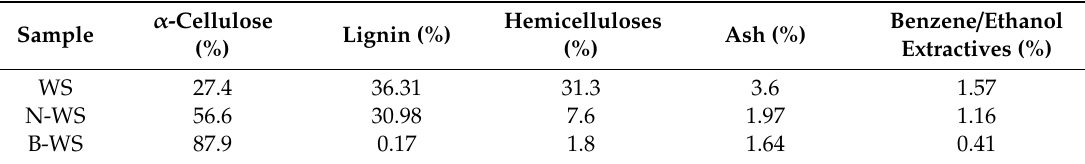
Table 1. Chemical components of walnut shell WS, walnut shell treated by NaOH (N-WS), and walnut shell after bleaching